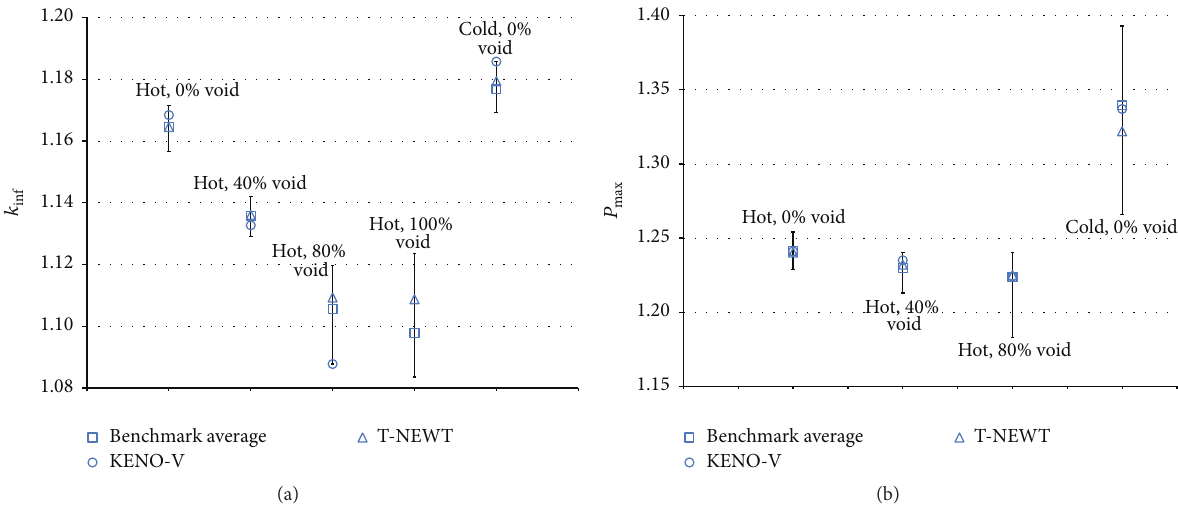
Figure 1: Comparison of SCALE code and benchmark results: (a) infinite multiplication factor and (b) power peaking